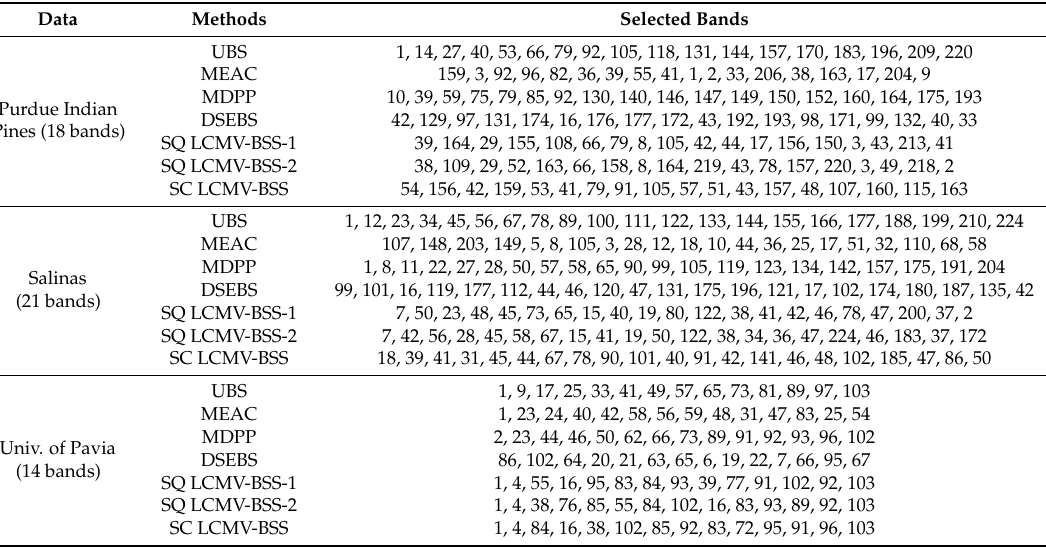
Table 2 lists the bands selected by seven BS methods—uniform BS (UBS), minimum estimated abundance covariance (MEAC), multigraph determinantal point process (MDPP), dominant set extraction BS (DSEBS), SQ LCMV-BSS-1, SQ LCMV-BSS-2, and SC LCMV-BSS—for the three scenes; n BS = 18 for Purdue’s Indian Pines, n BS = 21 for Salinas, and n BS = 14 for University of Pavia. Table 2. Bands selected by UBS, SQ LCMV-BSS-1, SQ LCMV-BSS-2, SC